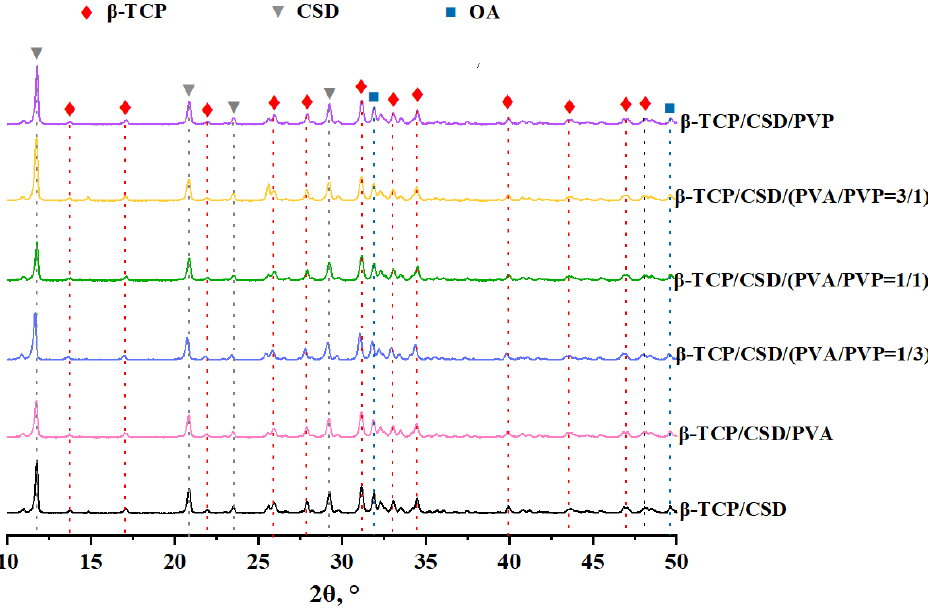
Figure 2. Diffraction patterns of composite cement materials.